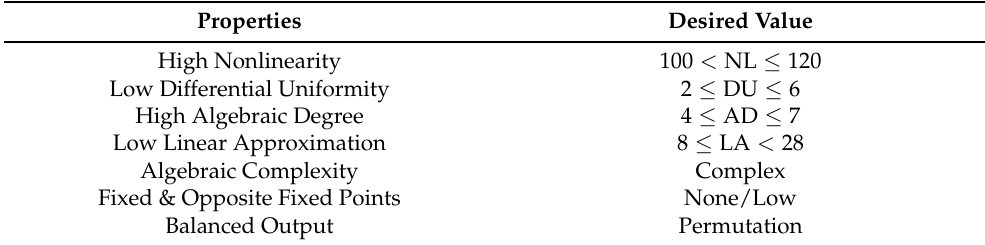
Table 1. Desired Value for Cryptographically Strong